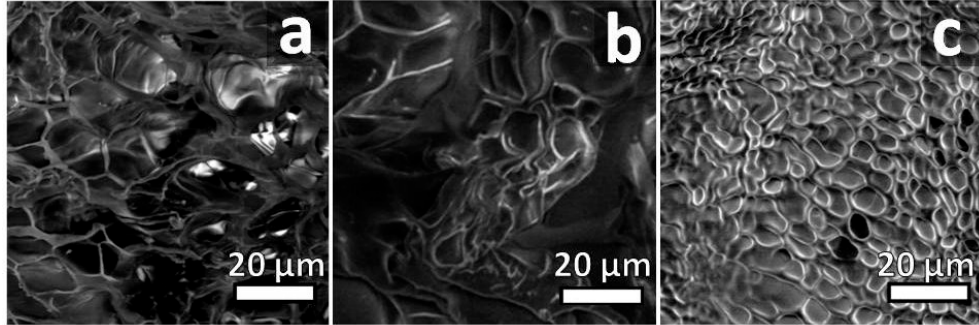
Figure 6. Representative SEM micrograph of gelatin samples ( a ) pristine gelatin and cross-linked with 1 in ( b ) 0.5:1 and ( c ) 5:1 TAD 1 /tyrosine ratio respectively. 1 in ( b ) 0.5:1 and ( c ) 5:1 TAD 1 /tyrosine ratio